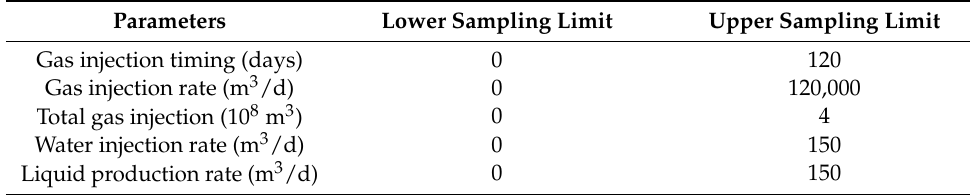
Table 1. Latin hypercube sampling upper and lower limits.